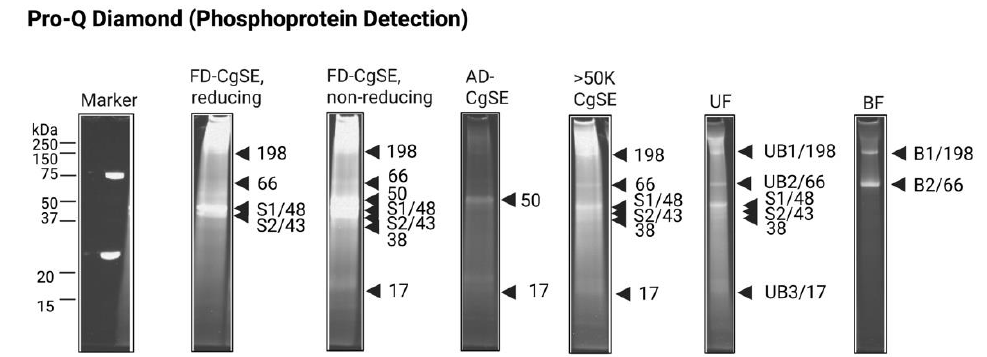
Figure 2. Enzymatic deglycosylation and glycoprotein staining profiles. ( A ) Unbound and Bound fractions eluted from WGA affinity chromatography were enzymatically deglycosylated with PNGase F (P), O -glycosidase (O), and Neuraminidase (N). Ten µg of each sample was loaded on a 12% SDS-PAGE and the gel was stained by Pro-Q emerald for Glycoprotein detection. ( B ) The gel was subsequently double-stained with QC-Colloidal Coomassie (QC-CC) Stain. Abbreviations: UF, Unbound Fraction; BF, Bound Fraction; UB1-UB3, B1, B2, DG1, DG2, S1, and S2 bands correspond to the identified proteins in the mass spectrometry analyses and are summarized in Tables 1 and 2.